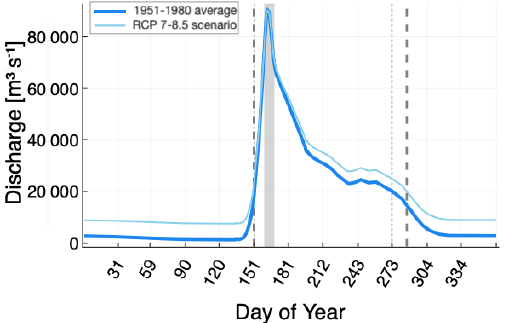
Figure 8. Daily discharge measured at Stolb station (thick blue line; GRDC Station Data 2903430, 2018), averaged from 1951 to 1980 inclusive. Discharge remains over 20000m 3 s − 1 during the months from June to September (between the thin grey dotted lines), which is the simulation period for the 4-month Lena-approximant cases. The grey band spans the peak 10d of discharge. The light-blue, thinner line shows the same discharge pattern, except the overall discharge has been scaled up by 35% (representing the RCP7–8.5 scenario) whilst keeping the peak value and the shape of the curve the same. The period during which discharge is over 20000m 3 s − 1 is longer, at 136d (between the thick grey dashed